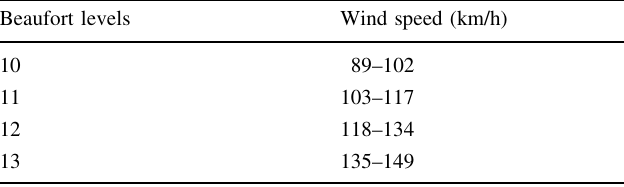
Table 1 Wind speed at different Beaufort levels Beaufort